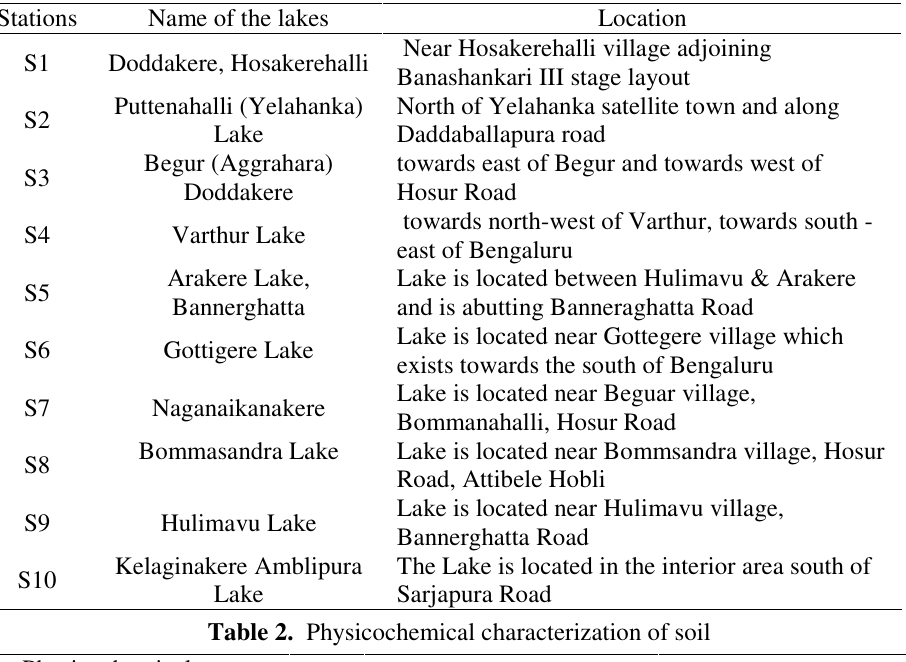
Table 1. Lakes stations and their locations in Bengaluru